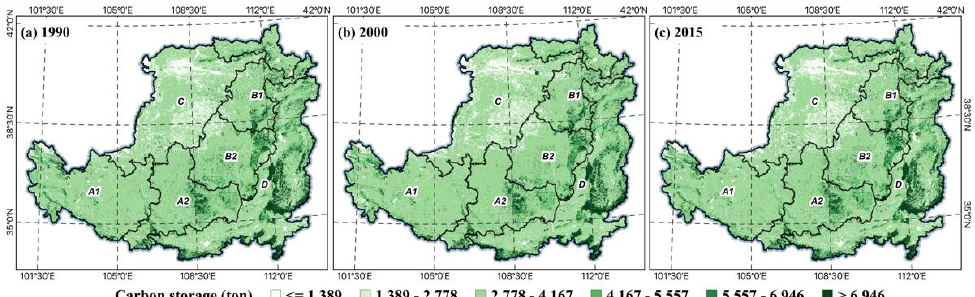
Figure 3. Carbon storage change in the LP, 1990 ( a ), 2000 ( b ), 2015 ( c